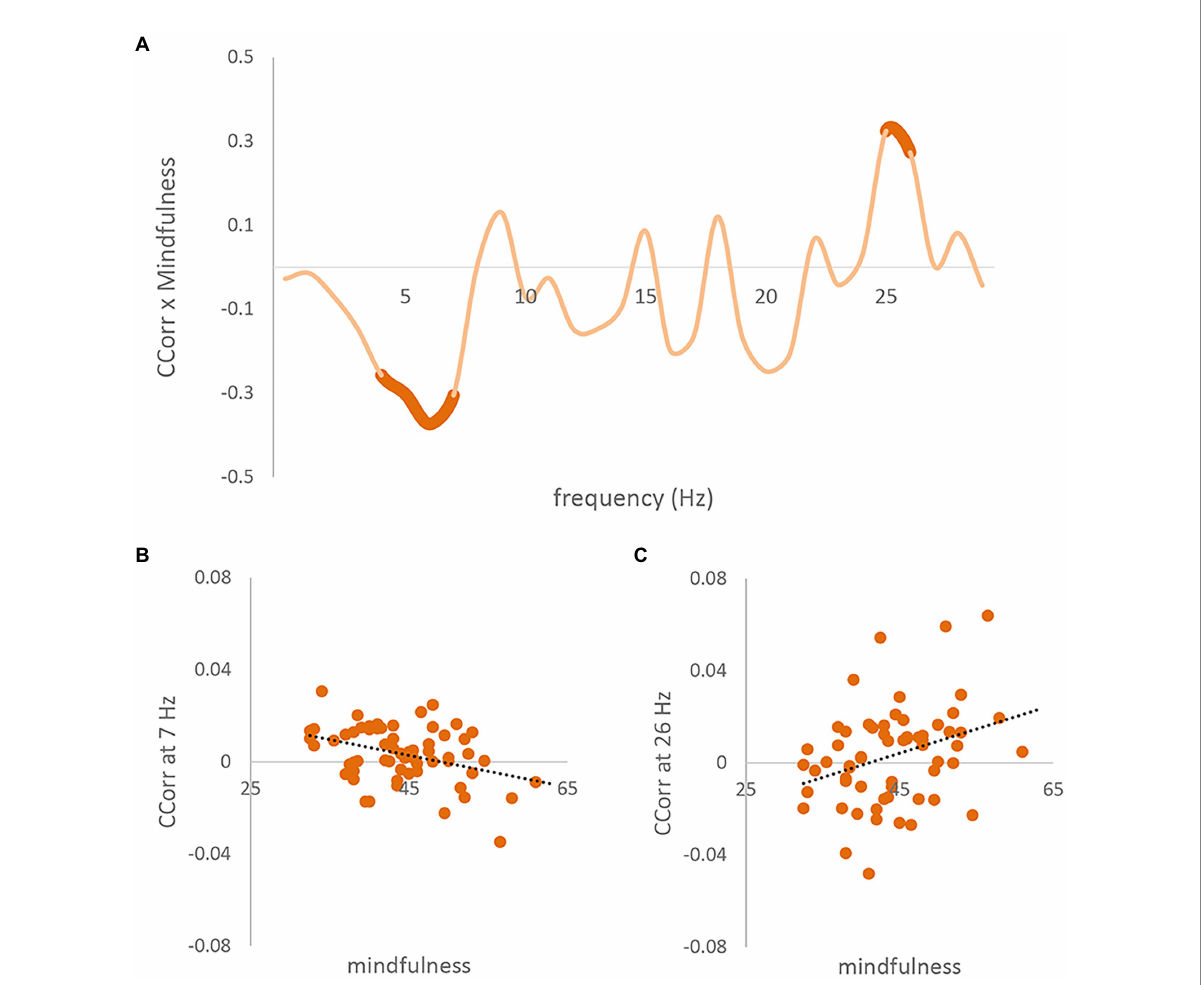
FIGURE 2 Correlation results between trait mindful awareness and CCorr. (A) Pearson correlation coefficients ( y -axis) between pair-averaged MAAS and inter-brain coupling (CCorr), for each 1-Hz frequency bin from 1 to 30 Hz ( x -axis). Two significant clusters (monte-carlo p = 0.002) are highlighted in bold. (B) Scatter plot between CCorr at 7 Hz and pair-averaged MAAS. The dotted line is the linear regression line. [r(62) = − 0.373]. (C) Scatter plot between concatenated CCorr at 26 Hz and pair-averaged MAAS scale [r(62) =